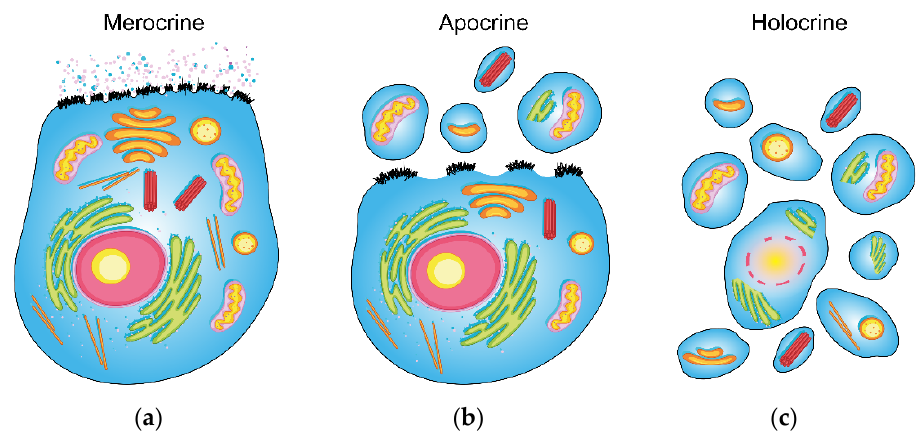
Figure 1. Schematic visualization of the three main types of sweat secretion (the design was adopted from Graphics RF, www.vecteezy.com, accessed on 1 July 2021). The general epithelial cell (with apical membrane) was chosen for the demonstration of: ( a ) merocrine, ( b ) apocrine and ( c ) holocrine secretion (a more detailed description of the mechanisms is provided in the introduction).